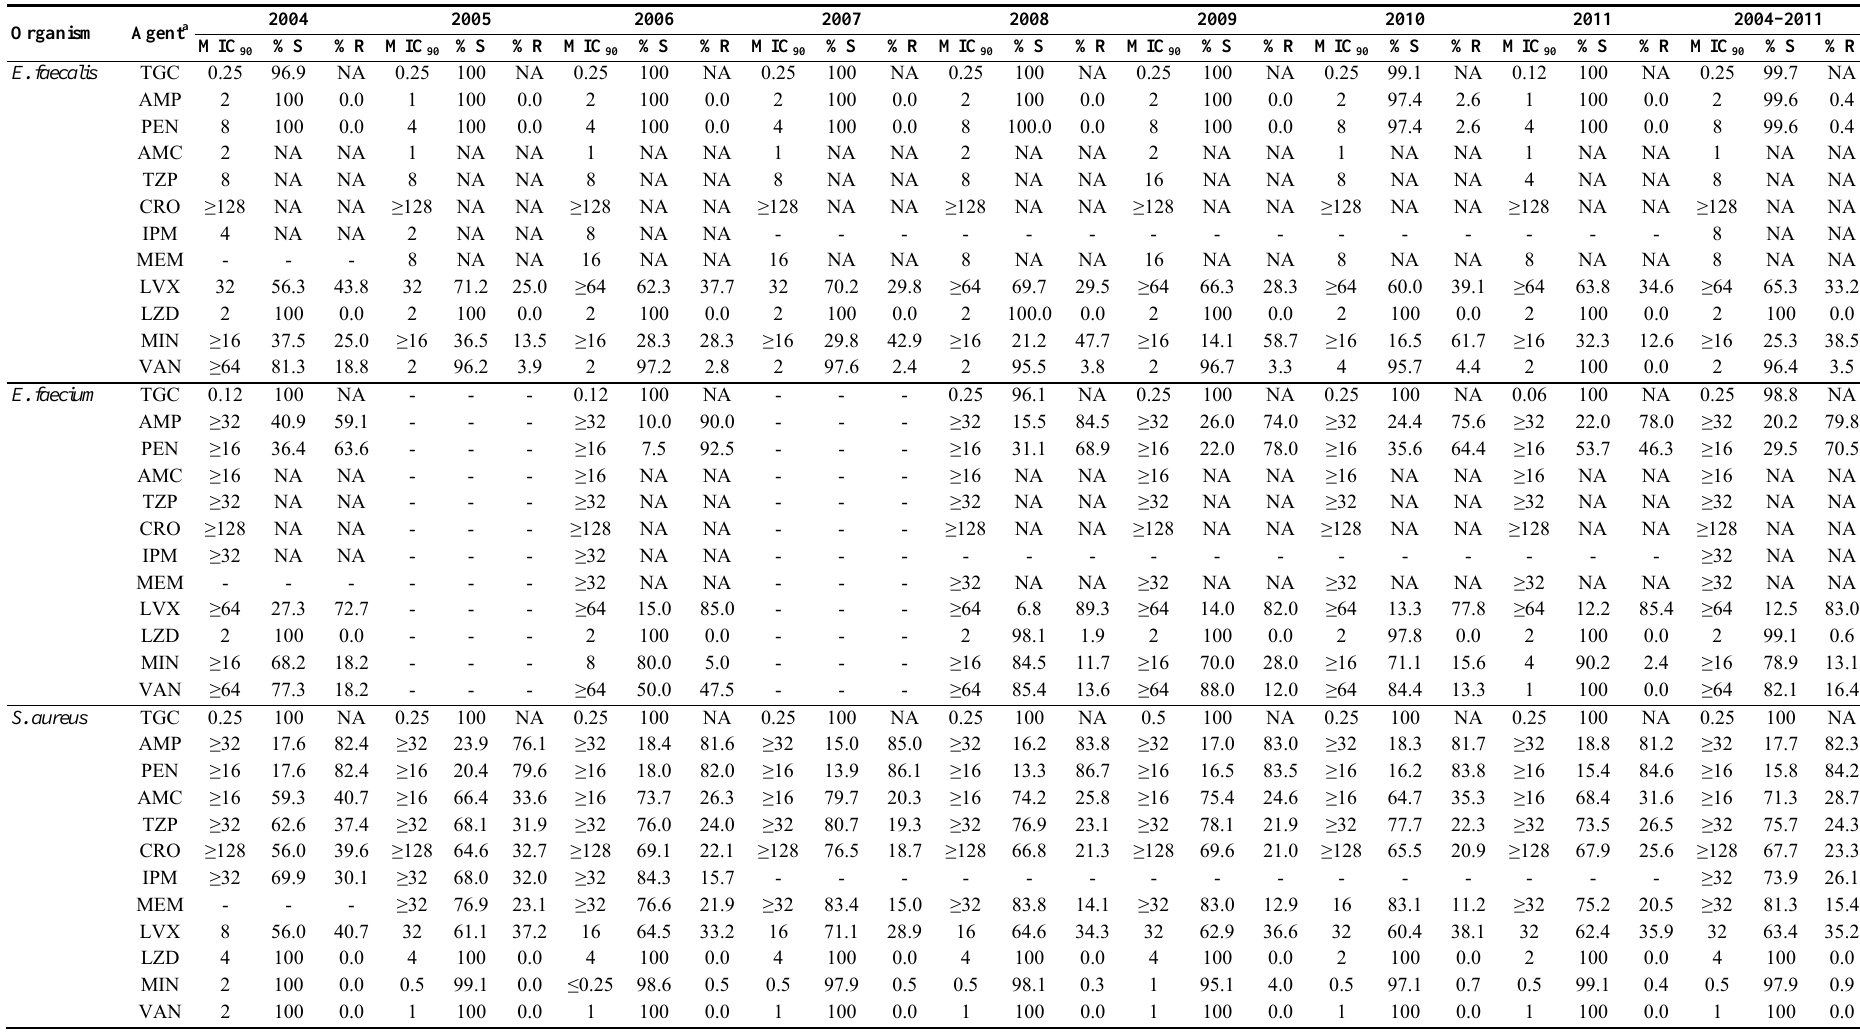
Table 3. MIC (mg/L), antimicrobial susceptibility (%S), and antimicrobial resistance (%R) for Gram-positive isolates collected in Italy 90 during T.E.S.T.